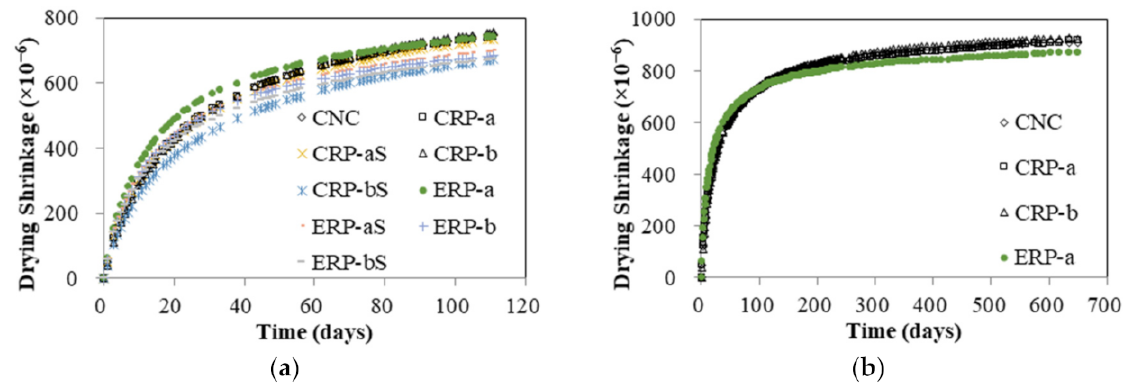
Figure 8. Drying shrinkage test results: ( a ) all specimens tested for 111 days and ( b ) some specimens tested for 648 days.